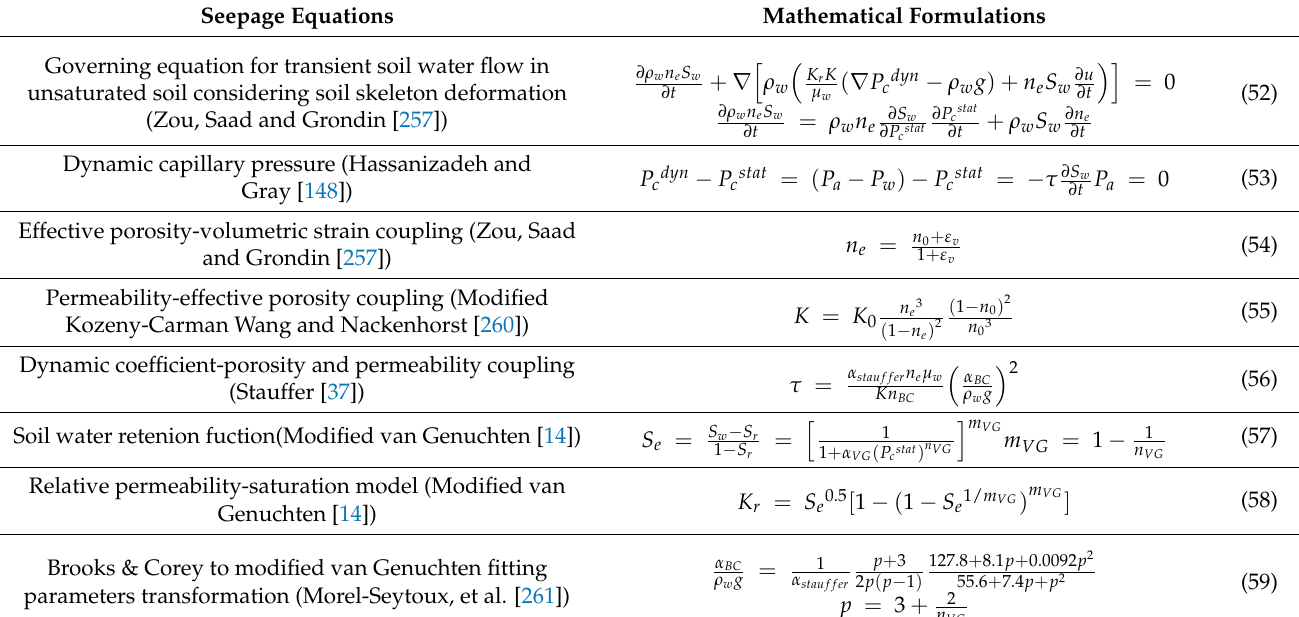
Table 6. The entire theoretical framework for modelling unsaturated soil elastic deformation in coupled with the thermodynamic-based theory of transient soil gas-water flow in unsaturated soil. Seepage